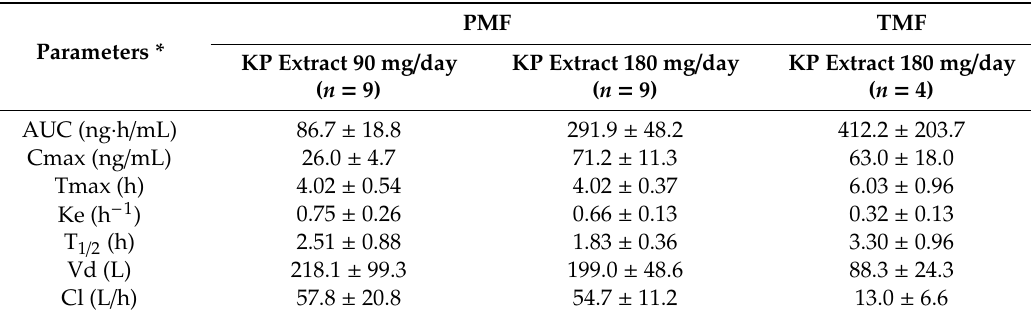
Figure 3. Blood concentration and time profile of PMF and TMF in normal subjects after receiving 90 and 180 mg/day of KP extract ( : PMF concentration in KP extract 90 mg / day group ( n = 5) , : PMF concentration in KP extract 180 mg / day group ( n = 9 ) , : TMF concentration in KP extract 180 mg / day group ( n = 4 )) . PMF: 3,5,7,3 ,4 - pentamethoxyflavone, TMF: 5,7,4 - trimethoxyflavone, KP: Kaempferia parviflora . Table 5. Pharmacokinetic parameters.